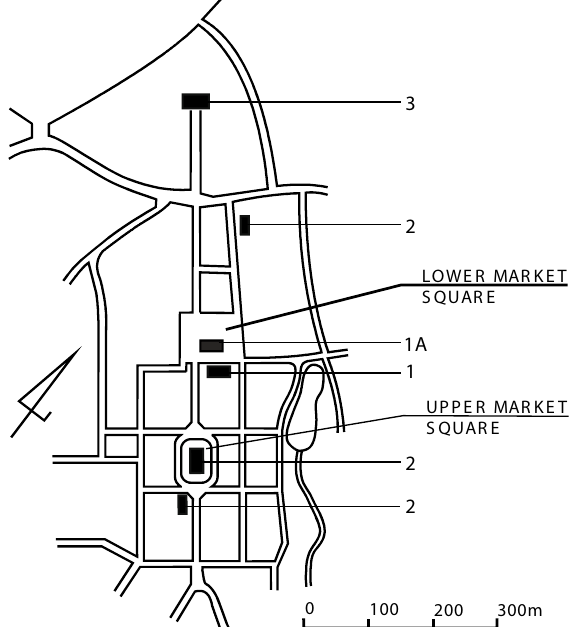
Fig. 6. Plan of Twardogóra town with axial urban system with two market squares: 1 – former town hall; 1A – present town hall; 2 – church; 3 – palace